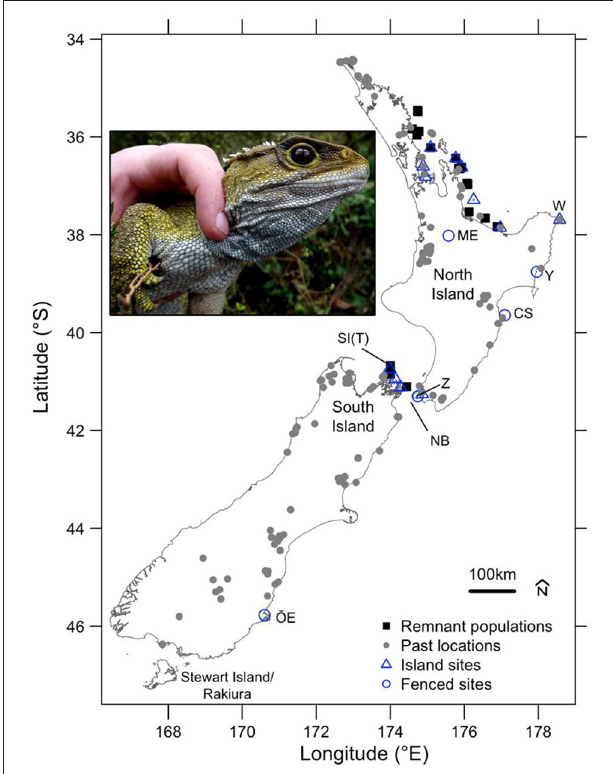
FIGURE 1 | Map: Tuatara remnant and past locations as well as translocation release sites. Past locations (grey circles) from Holocene-aged fossil deposits (last 11,650 cal years BP, as determined by biochronological reasoning, namely the dominance of the moa Anomalopteryx didiformis; Worthy and Holdaway, 2002) and other known or probable extinctions from offshore islands (Cree, 2014). The remnant populations (black squares) and translocation sites (blue outlines) are split into groups of island and fenced sites, as these entail more conservative and extrapolative translocations, respectively. Locations of key places mentioned in the text are listed from north to south: W, East Island/Whangaokeno; ME, Maungatautiri Ecological Island; Y, Young Nick’s Head; CS, Te Matau a Maui—Cape Sanctuary; SI(T), Stephen Island (Takapourewa); Z, ZEALANDIA; NB, North Brother Island; OE, Orokonui Ecosanctuary; Inset, An adult male tuatara about to be reintroduced to OE; photo by SJ. Adapted from Cree (2014) and Jarvie et al.